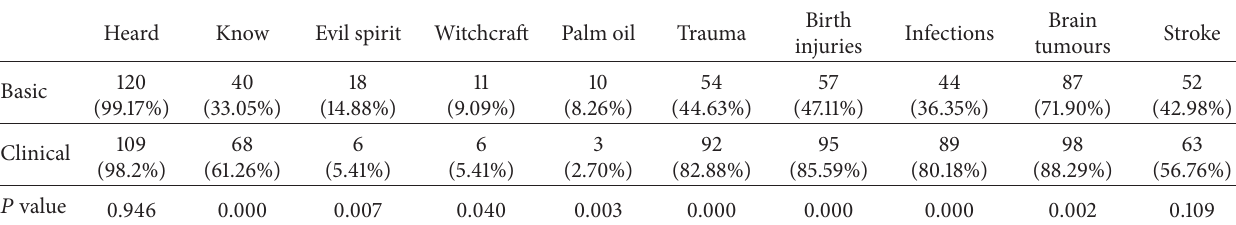
Table 1: Awareness and proposed causes of